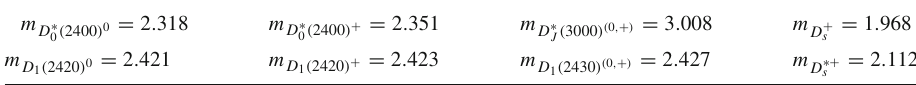
( 2400 ) 0 , + strong 0